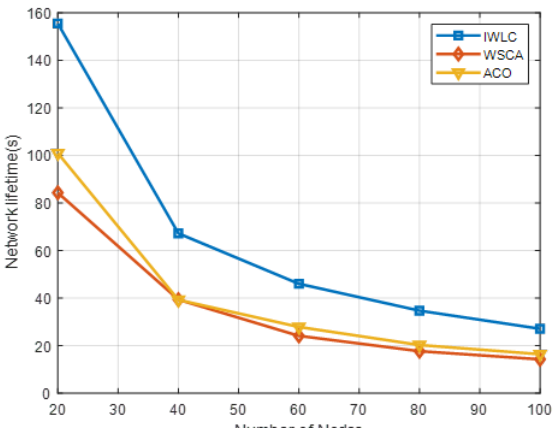
Figure 11. Network lifetime in different clustering schemes with varying numbers of UAV nodes.